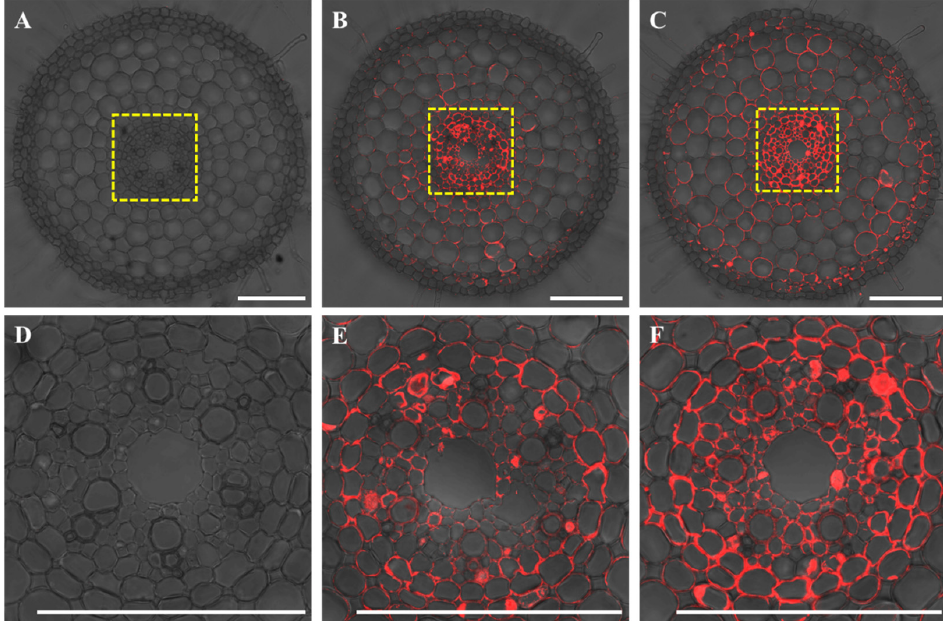
Figure 3. Tissue and cell specificity of OsWRKY54 expression. The wild-type rice ( A ) and ProOsWRKY54:GFP transgenic rice ( B , C ) were exposed to 0 ( A , B ) or 100 mM NaCl ( C ) for 12 h. Roots were used for immunostaining. ( D – F ) represents the magnified image of the yellow boxed area in ( A – C ), respectively. Red shows the signal of the anti-GFP antibody. Scale bar = 100 μ m.